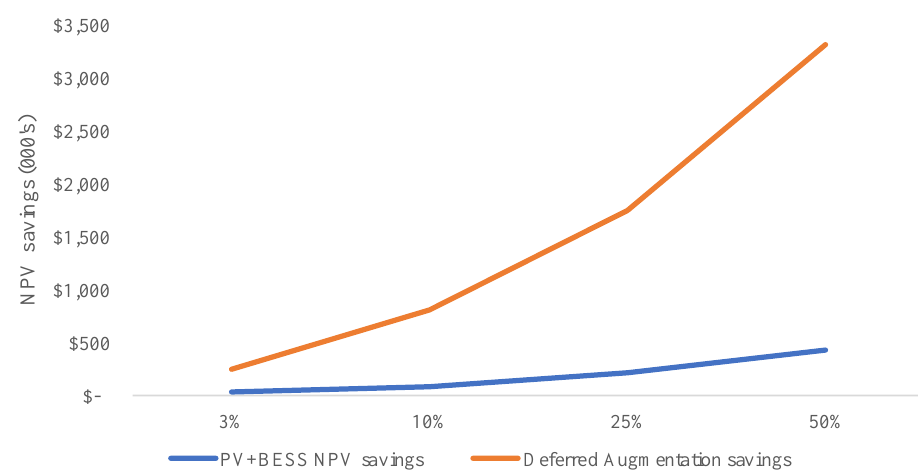
Figure 16. Private and network savings by scenario.